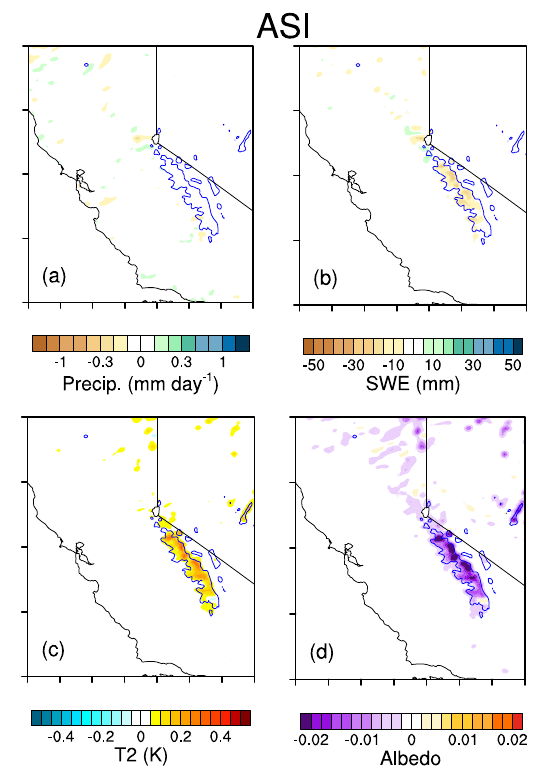
Figure 7. ASI effects (CTRL – NASI) on spatial distributions of (a) precipitation (mmday − 1 ) , (b) SWE (mm), (c) T2 (K), and (d) surface albedo. Blue lines represent the mountaintops with elevation ≥